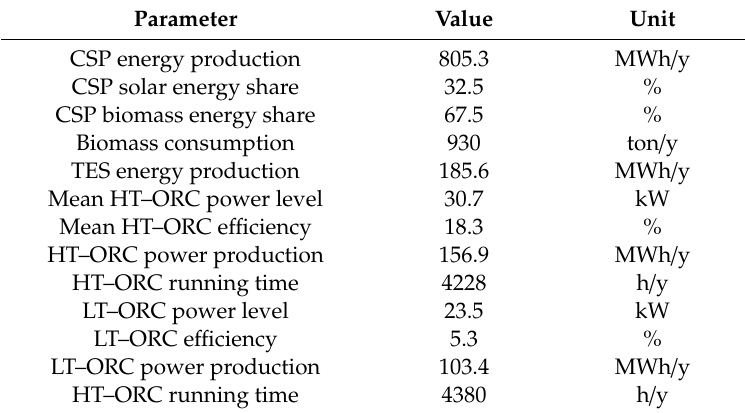
Figure 7. Temperature—Entropy diagram of LT–ORC ( a ) and HT–ORC ( b ) at design conditions. Table 8. Expected plant performances.